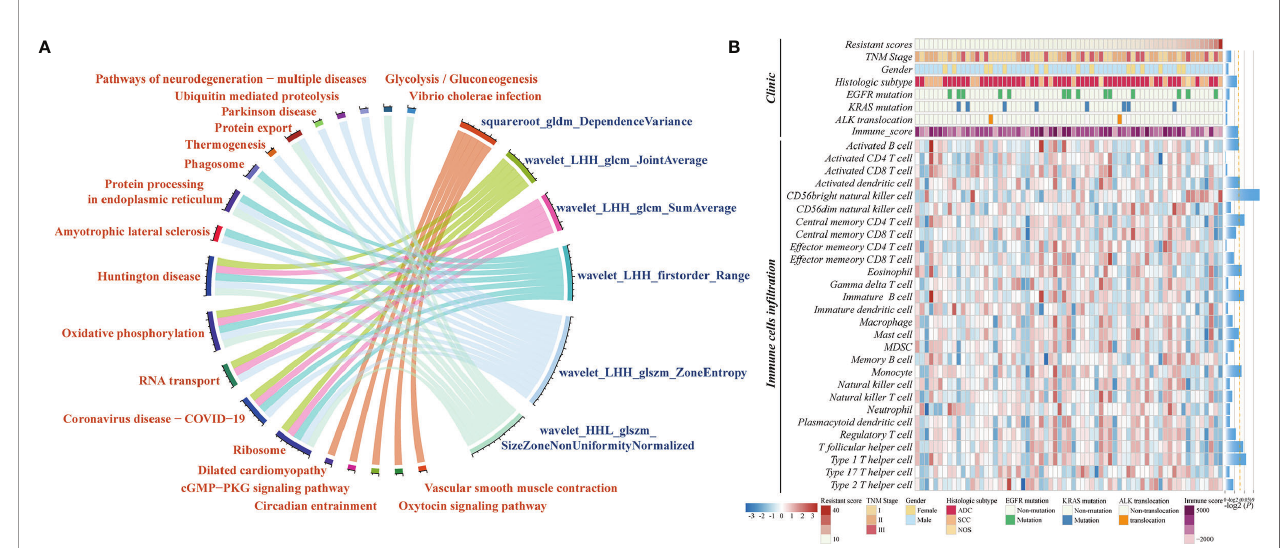
FIGURE 5 | Molecular characteristics associated with CCR-9RS in NSCLC. (A) Gene-enrichment analysis of correlated genes with 6 radiomic features in CCR-9RS based on the Kyoto Encyclopedia of Genes and Genomes (KEGG) database in the NRG (NSCLC-Radiogenomics) dataset. (B) Molecular lesions and immune landscapes along with the resistant scores calculated by CCR-9RS. The correlation was estimated by Spearman rank correlation. The histogram on the right represents the signi fi cantly correlation with the resistant scores of CCR-9RS; the orange-dotted line represents P =